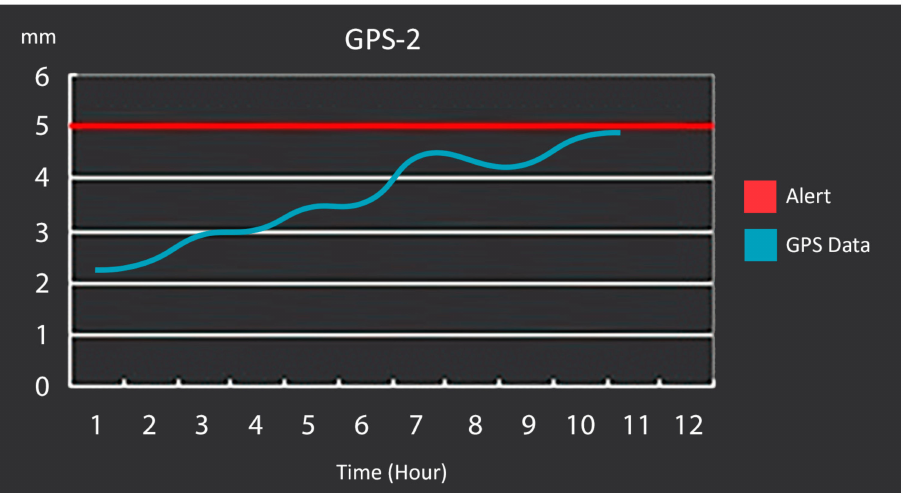
Figure 7. A detailed data display of the retractable meter.